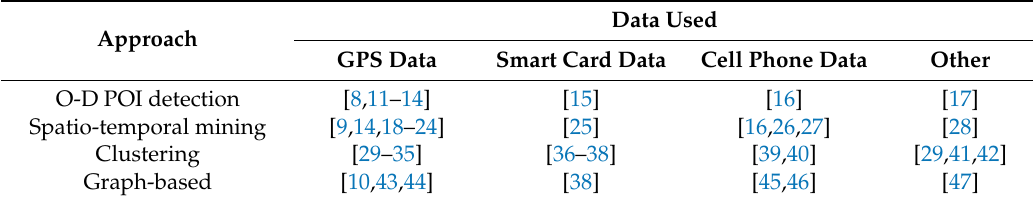
Table 1. Classification of trajectory-based studies.